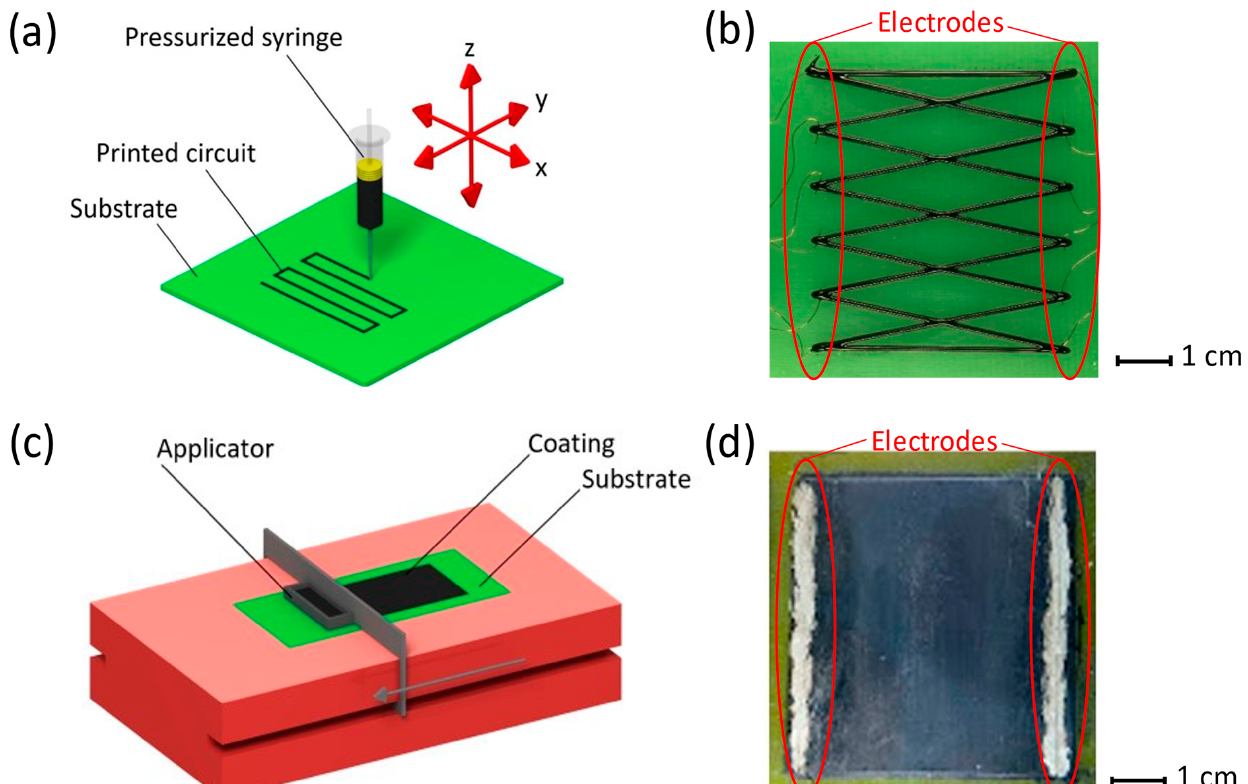
Figure 1. Schemes of the manufacturing techniques and examples of specimens: ( a ) Direct Write 3D printing scheme, ( b ) an example of a 3D-printed circuit specimen, ( c ) coater scheme, and ( d ) an example of a coating specimen.